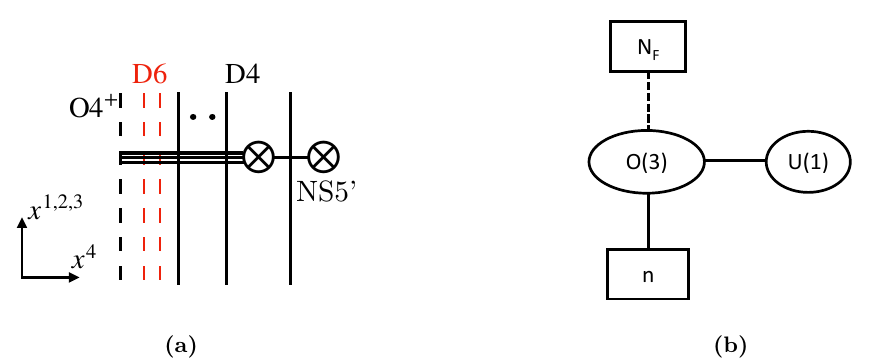
Figure 33. (a): the brane configuration for the monopole screening sector v = 0 of T (b): the corresponding quiver